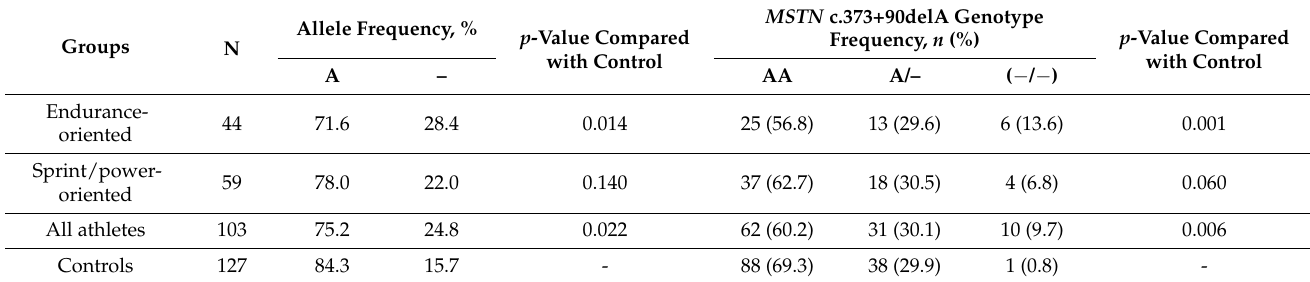
Table 1. Genotype and allele distributions of the MSTN rs11333758 polymorphism in Lithuanian elite athletes and controls.